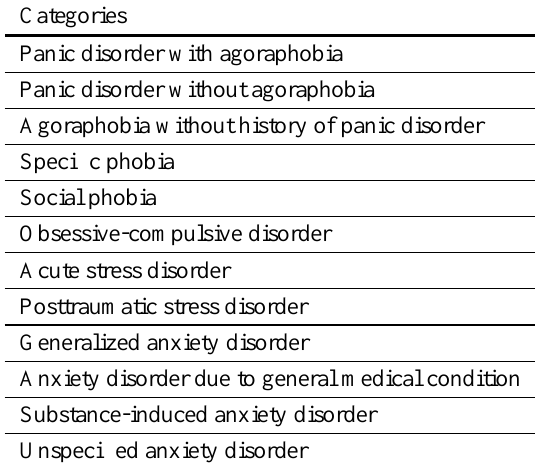
DSM IV classification of primary anxiety